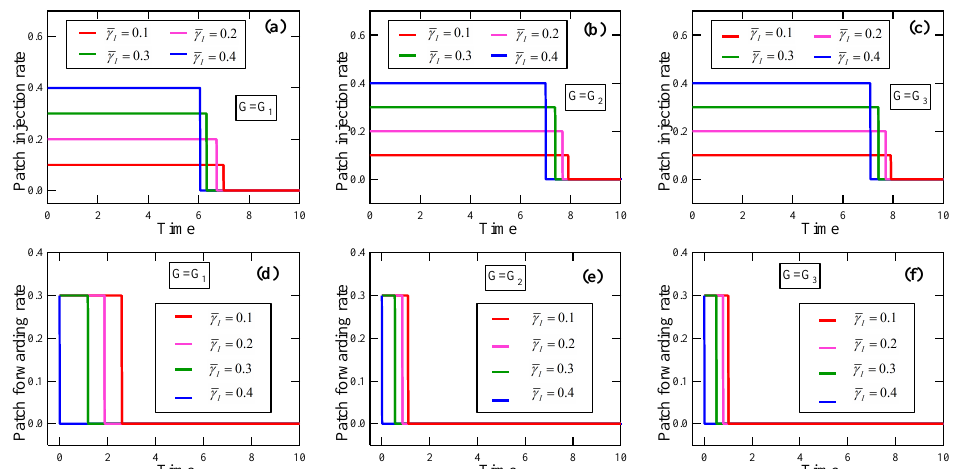
Figure 12. The experimental results in Experiment 2 about the effect of the maximum allowable patch injection rate on the optimal patching strategy. ( a ) Patch injection rate, G = G 1 ; ( b ) Patch injection rate, G = G 2 ; ( c ) Patch injection rate, G = G 3 ; ( d ) Patch forwarding rate, G = G 1 ; ( e ) Patch forwarding rate, G = G 2 ; ( f ) Patch forwarding rate, G = G 3 .